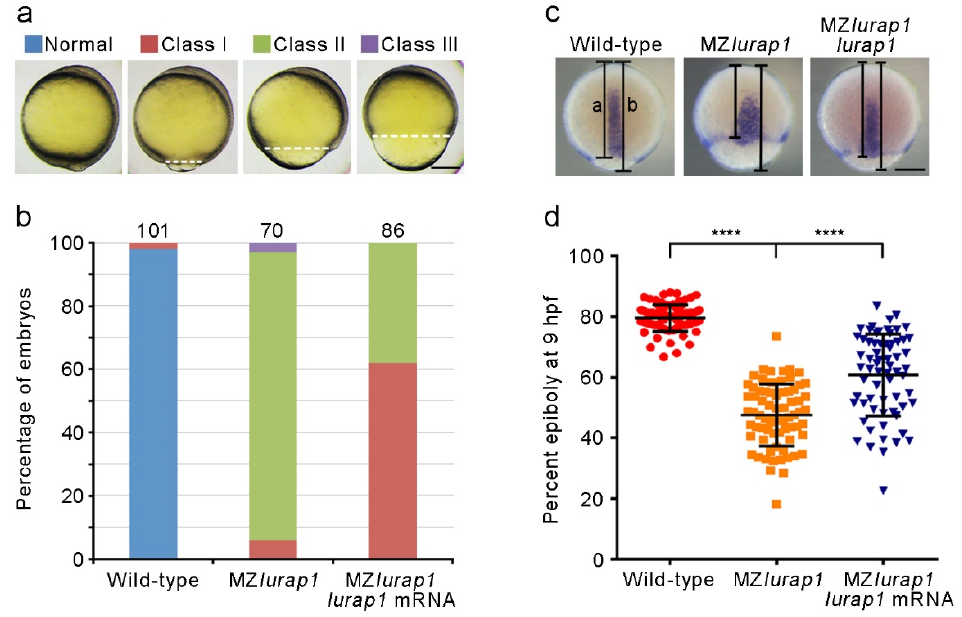
Figure 2. Rescue of epiboly delay in MZ lurap1 mutant embryos by Lurap1. ( a ) Classification of the severity of epiboly delay at 10 hpf: normal embryos complete epiboly; class I embryos reach 90% epiboly; class II embryos show 75% to 90% epiboly; class III embryos fail to accomplish 75% epiboly. Broken lines indicate the leading edge of the blastoderm margin. Scale bar: 200 µm. ( b ) Graph shows the proportion of embryos with different degrees of epiboly delay. Numbers on the top of each stacked column represent total embryos scored from three independent experiments, and color keys are as indicated in ( a ). The results were analyzed independently in a blended manner. ( c ) Determination of the rescue efficiency by in situ hybridization analysis of tbxta to visualize the leading edge of the blastoderm margin at 9 hpf. Epiboly progression was calculated as the distance from the animal pole to the edge of the blastoderm margin ( a ) relative to the length of the animal- vegetal axis ( b ). Scale bar: 200 µ m. ( d ) Scatter plot shows the rescue of epiboly progression in MZ lurap1 mutant embryos by wild-type lurap1 mRNA. Data are mean ± s.d. from three independent batches of embryos (****, p <